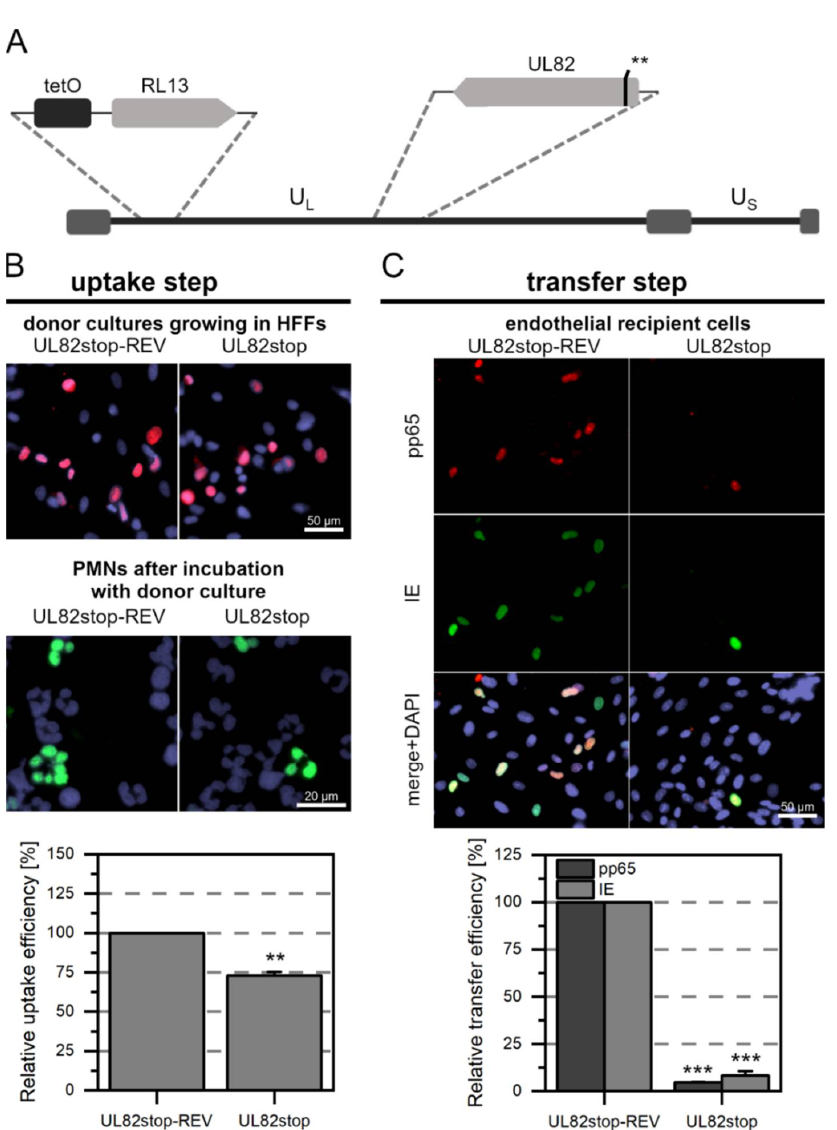
Figure 5. The tegument protein pp71 of HCMV is required for uptake into PMNs and subsequent transfer to endothelial cells. ( A ) Genomic overview of the generated Merlin mutant representing the unique long (U L ) and short (U S ) sections: the mutant carries the tet operator upstream of RL13. In comparison to the wild-type, two consecutive stop codons (**) were introduced into the ORF of UL82 as indicated. ( B ) Characterization of the uptake step to PMNs. PMNs were isolated from EDTA blood of HCMV-seronegative donors and incubated for 3 h at 37 °C with Merlin-RL13tetO- UL82stop or its revertant Merlin-RL13tetO-UL82stop-REV. PMNs were recollected, and a fraction